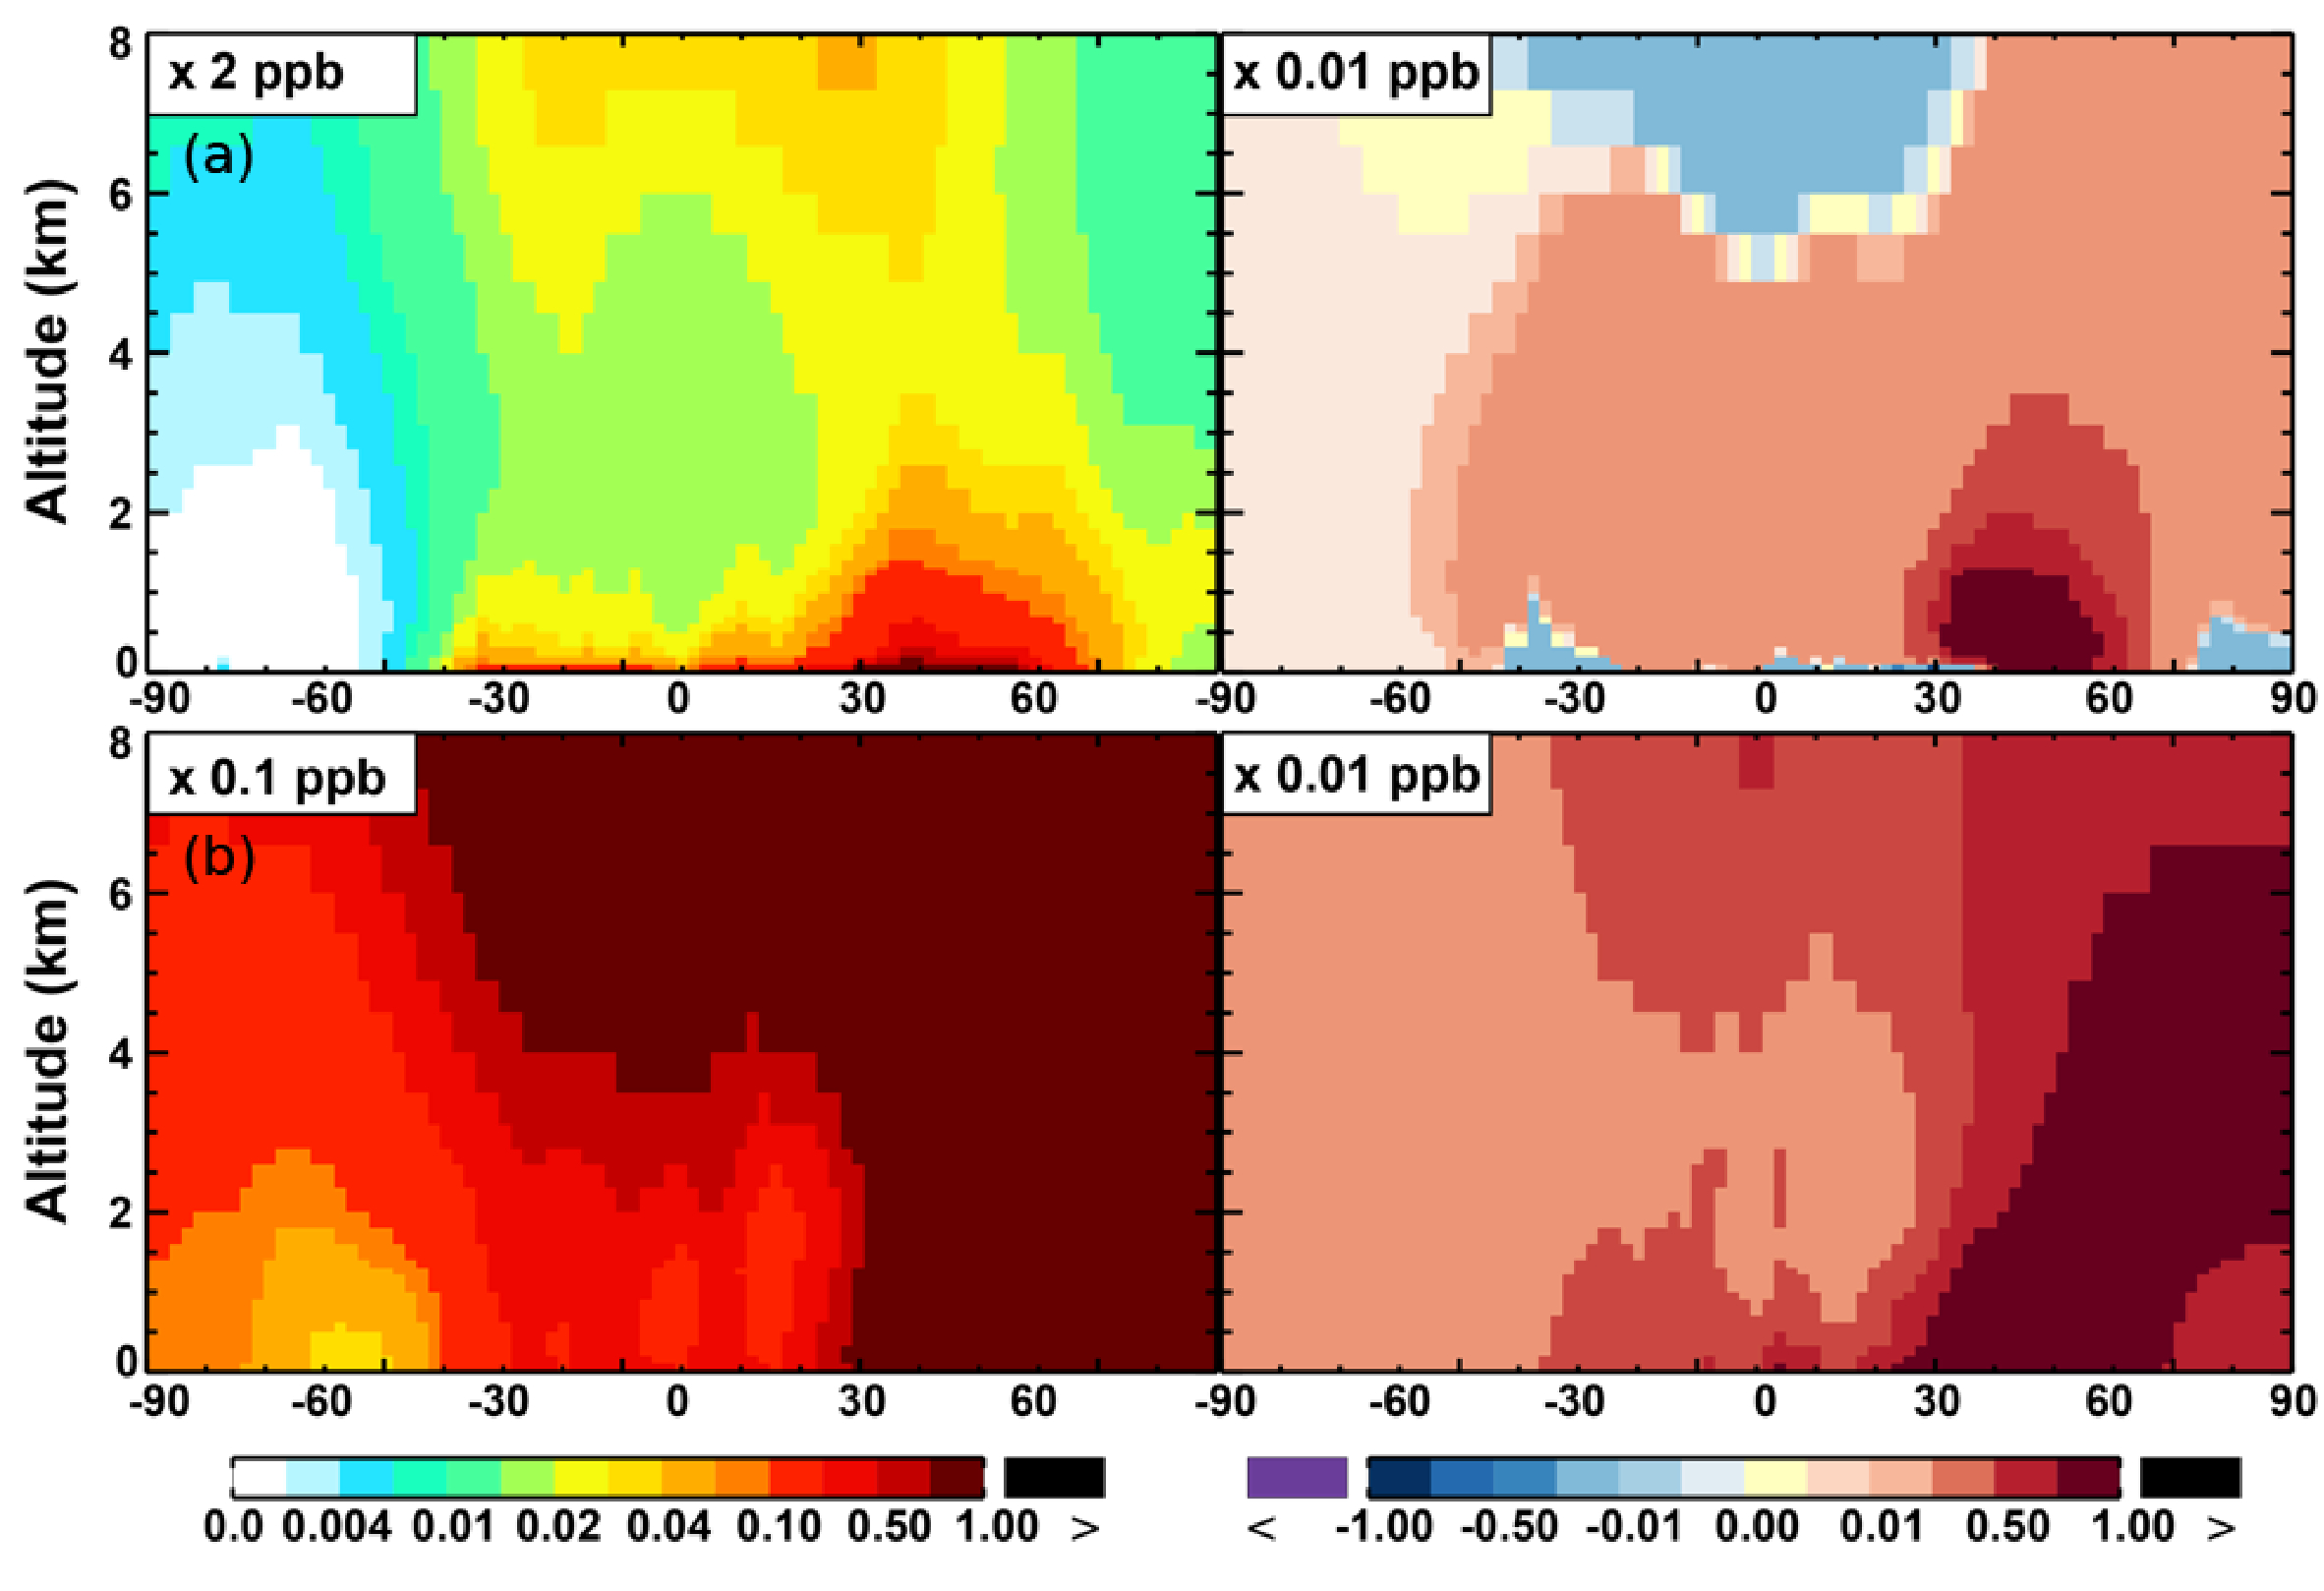
Same as Fig. 7 but for NOx
(a) and PAN (b).